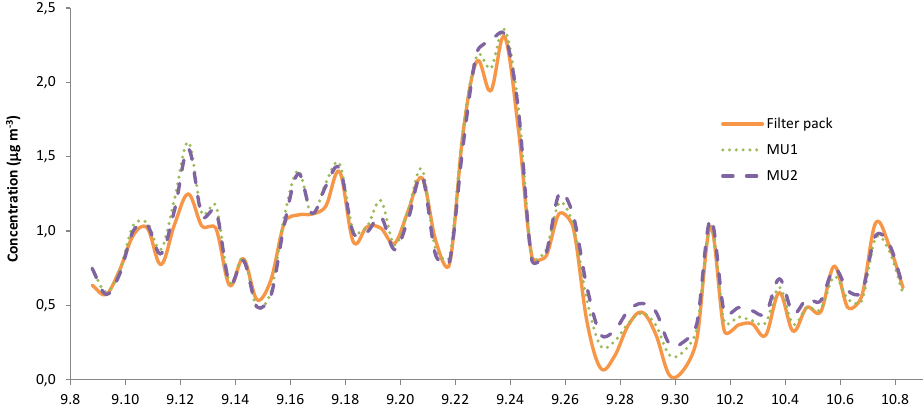
Figure 18. Filter pack and MU measured NH + Fig. 18. Filter pack and MUs measured NH 4+ concentrations (after adjusting for the external standard as an offset after 19:00 on 9/25) 2 September) during the ETV period. during the ETV period. 3